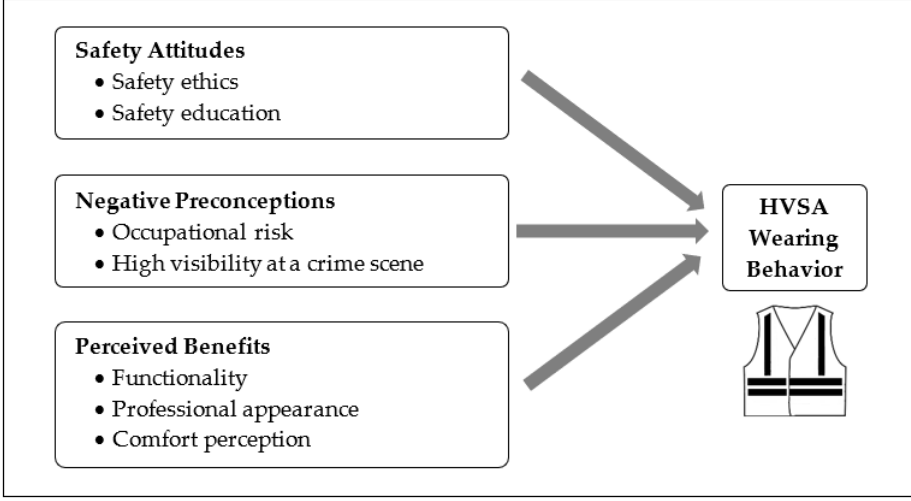
Figure 1. Conceptual framework of high-visibility safety apparel (HVSA).